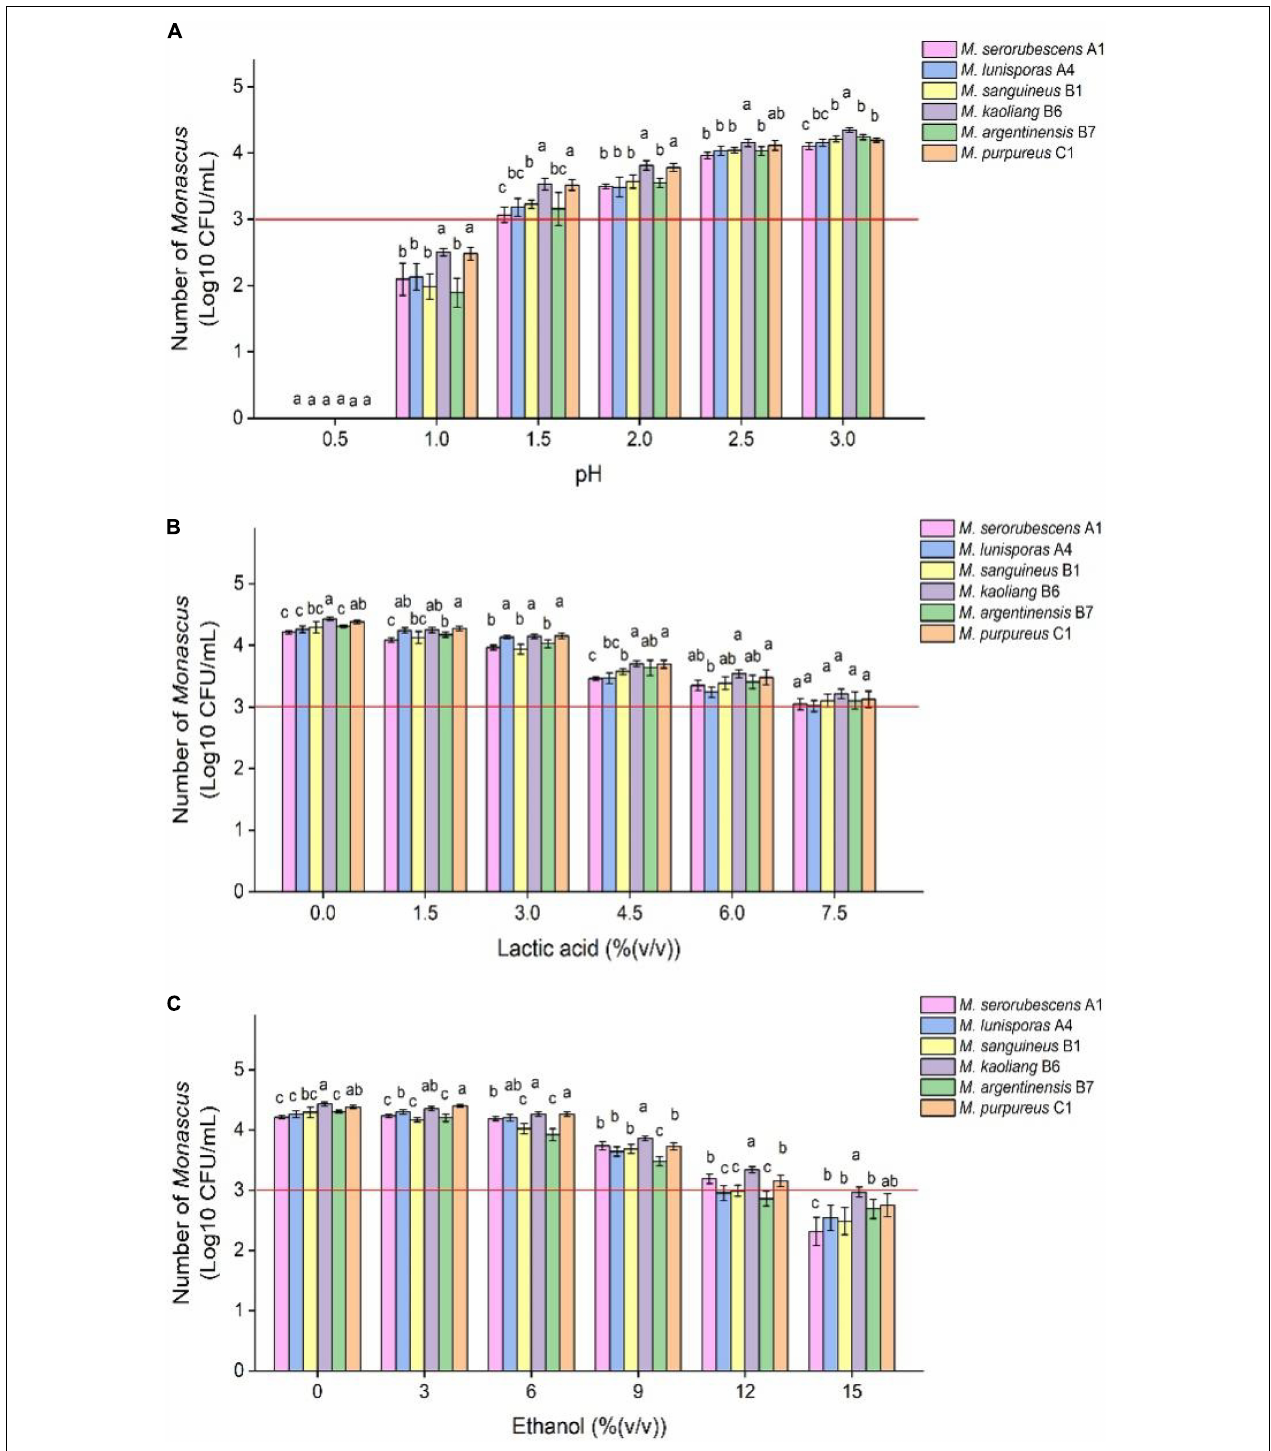
FIGURE 1 | Tolerance test of different species of Monascus to different growth inhibitors. The six Monascus species were cultured in restrictive medium containing different concentrations of HCl (A) , lactic acid (B) and ethanol (C) at 30 ◦ C and 200 r/min for 7 days, and the number of viable spores of Monascus was determined by plate coating after fermentation. Error bars indicate the standard deviation (SD) of the means ( n = 3), and different lowercase letters represent significant differences in the number of viable cells of different Monascus strains under the same treatment condition ( p < 0.05). The red auxiliary line indicates that the initial amount of Monascus is 1.0 × 10 3